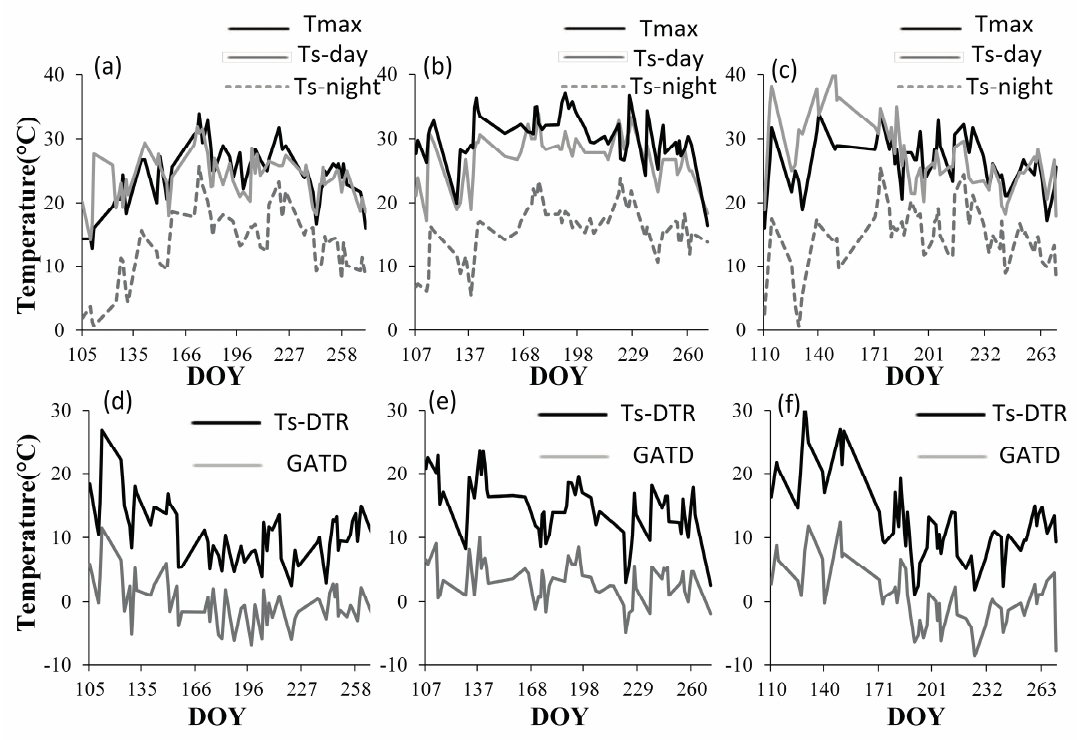
Figure 6. Typical Tmax, Ts-day and Ts-night (°C) curves ( a – c ), Ts-DTR and GATD (°C) curves ( d – f ), of three land-cover types: (a,d) deciduous forest (in Albia 3 NNE, 2009); (b,e) developed (in Columbus port Columbus international airport, 2009); and (c,f) crops (in Little Sioux 2 NW,